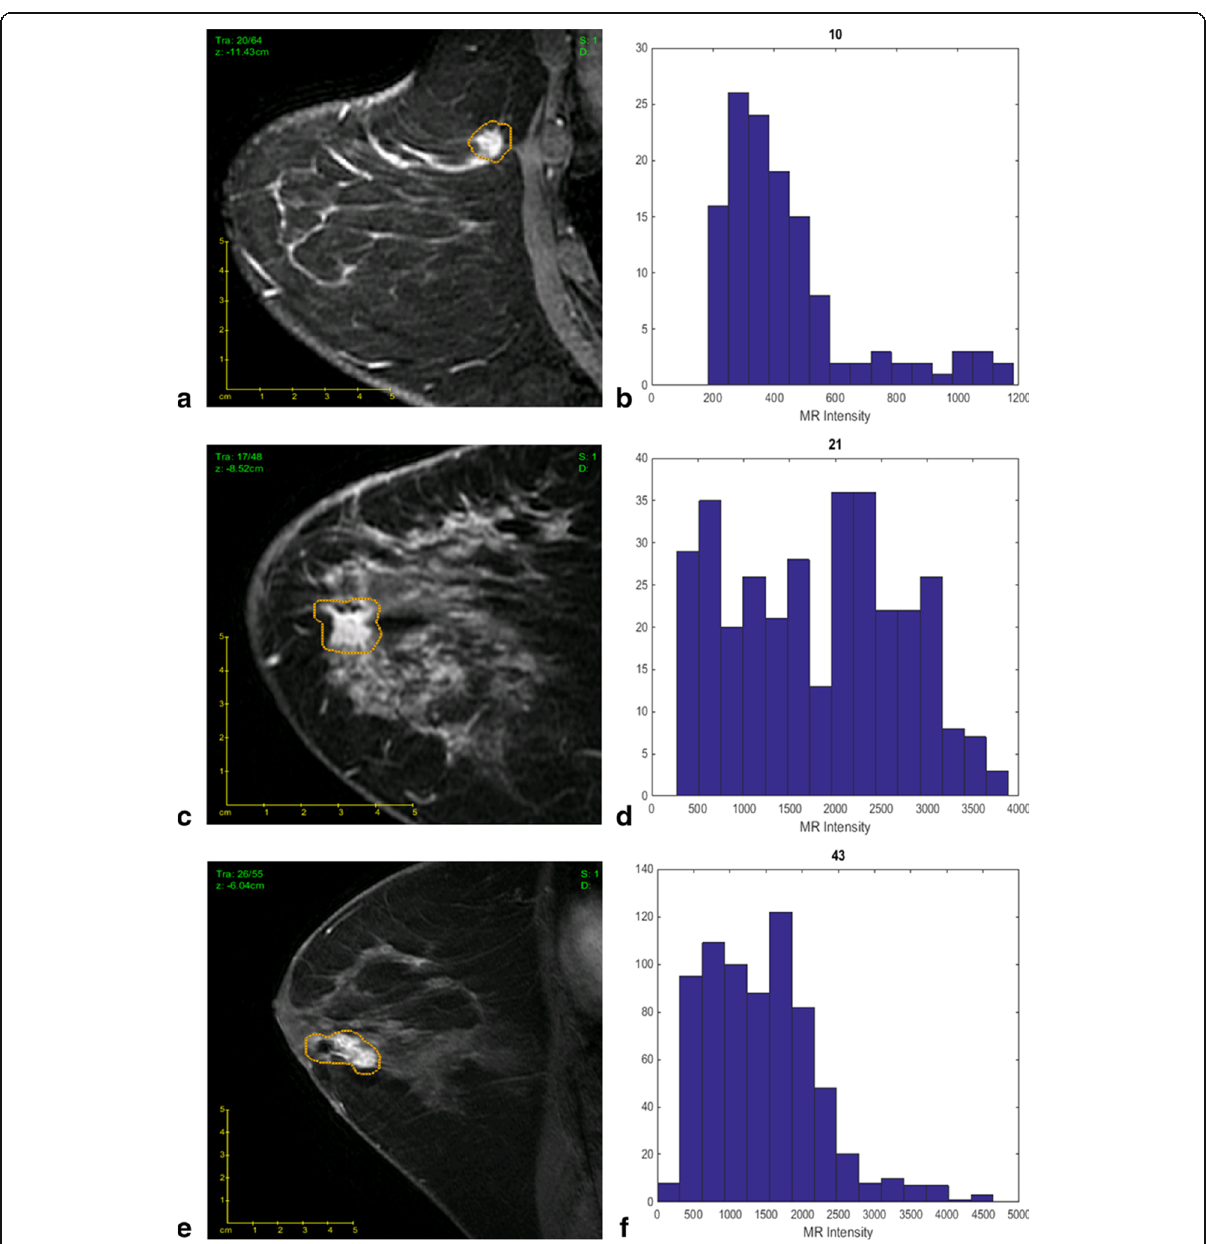
Fig. 2 The best-fit linear regression model allows imaging features to differentiate tumors with different Oncotype Dx Recurrence Score (ODxRS). a Sagittal T1-weighted fat-suppressed post-contrast MRI of an invasive ductal nuclear grade 1 carcinoma with an ODxRS of 10 and ( b ) corresponding kurtosis histogram, which demonstrates the frequency of MR intensity. c Sagittal T1-weighted fat-suppressed postcontrast MRI of an invasive ductal nuclear grade 2 carcinoma with an ODxRS of 21 and ( d ) corresponding kurtosis histogram. e Sagittal T1-weighted fat-suppressed postcontrast MRI of an invasive ductal nuclear grade 3 carcinoma with an ODxRS of 43 and ( f ) corresponding kurtosis histogram. Reprinted with permission from: J Magn Reson Imaging. 2015 Nov;42 [5]:1398 – 406. doi: https://doi.org/10.1002/jmri.24890 Breast cancer subtype intertumor heterogeneity: MRI-based features predict results of a genomic assay. Sutton EJ, Oh JH, Dashevsky BZ, Veeraraghavan H, Apte AP, Thakur SB, Deasy JO, Morris